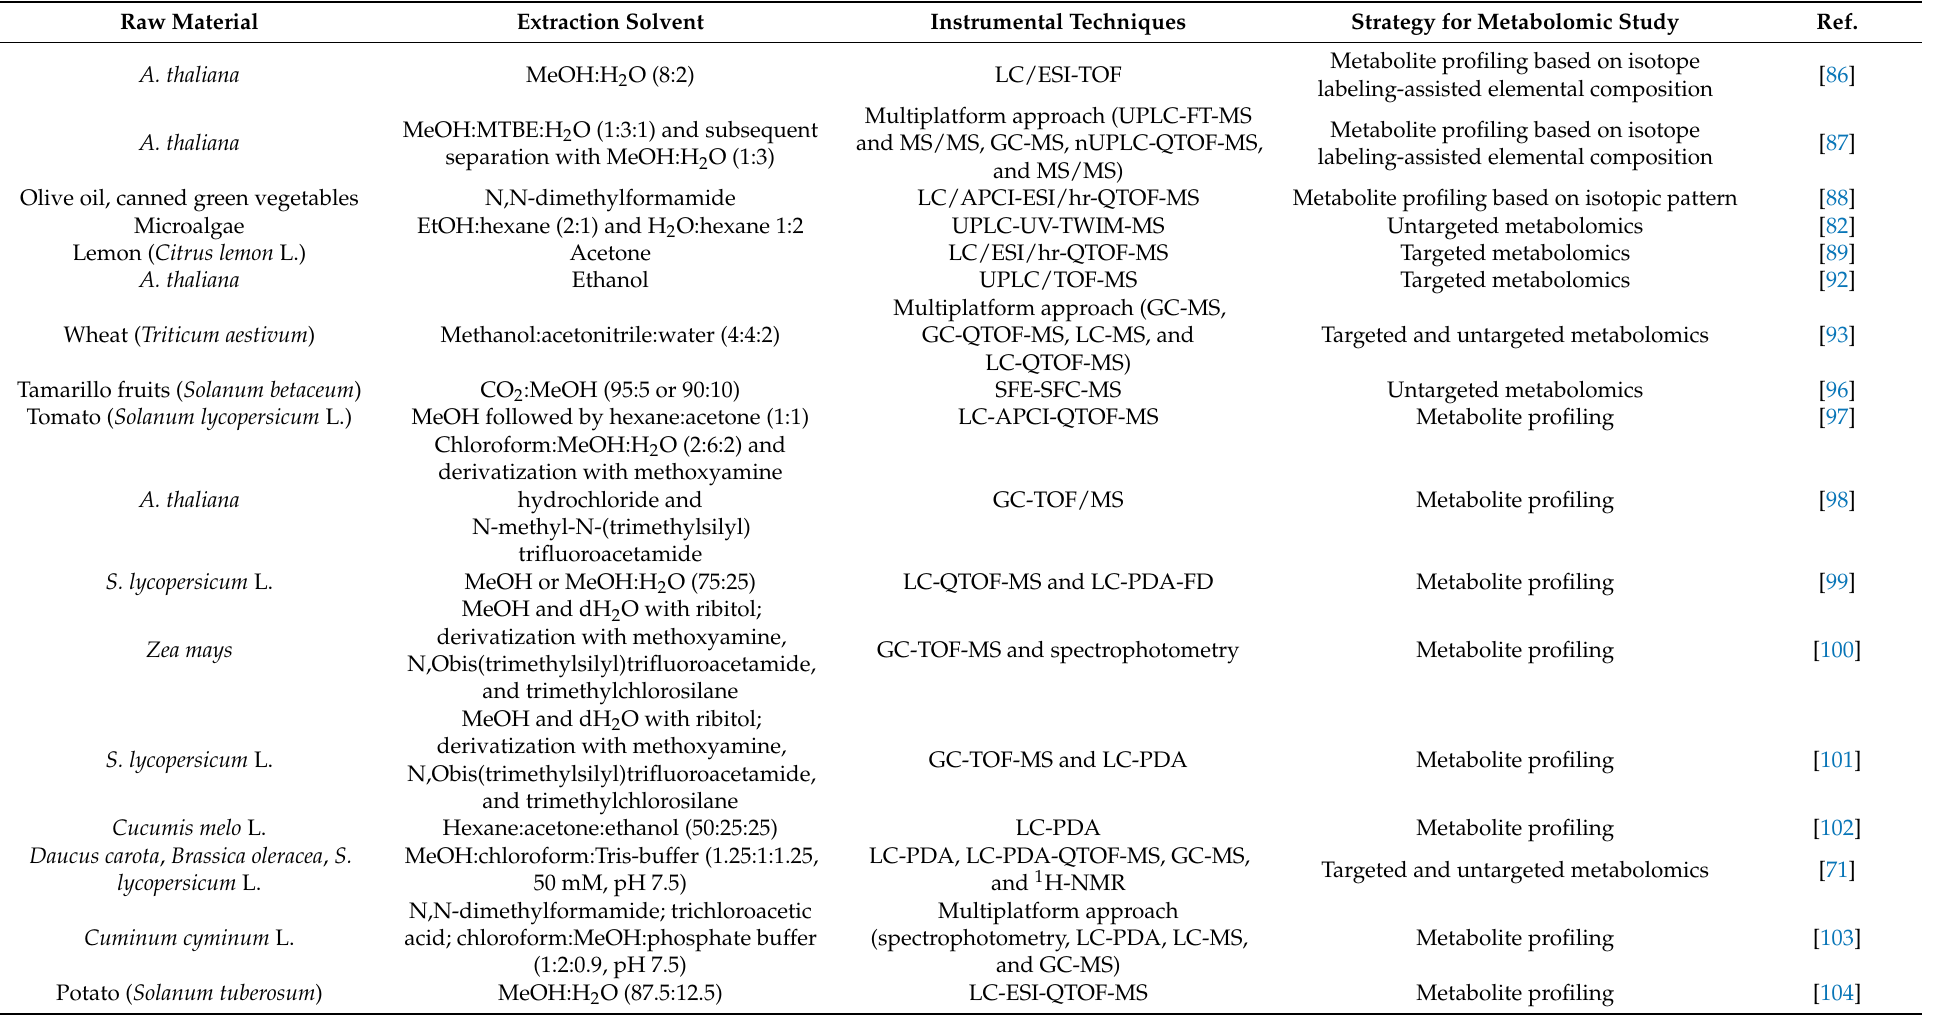
Table 1. Brief description of representative works addressing mass spectrometry in the analysis of chlorophylls and